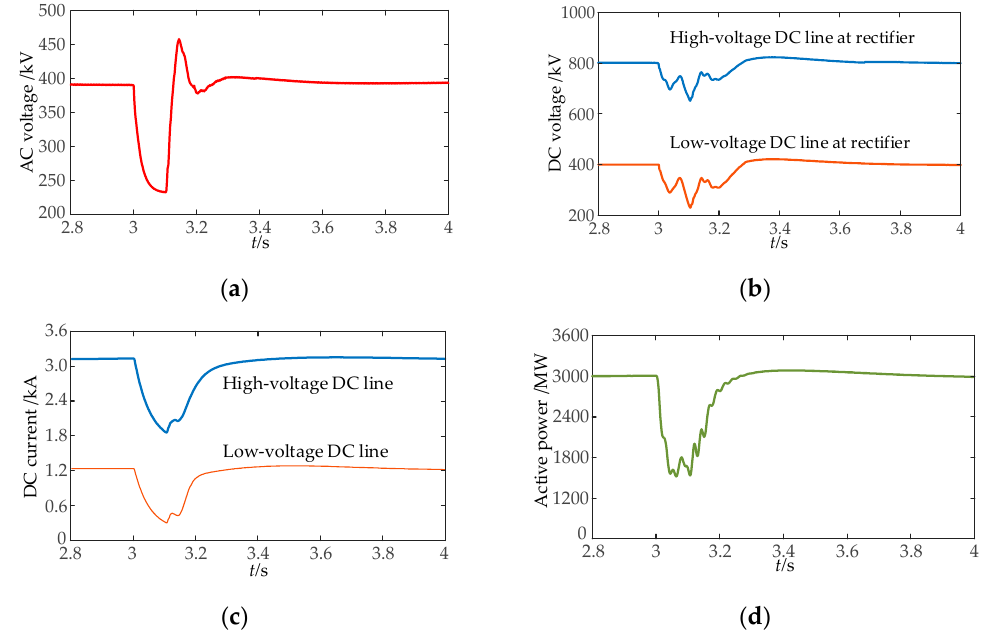
Figure 13. Waveform diagram under fault at rectifier side. ( a ) AC voltage at rectifier side. ( b ) DC voltage at rectifier side. ( c ) DC current of transmission line. ( d ) Active power of system.